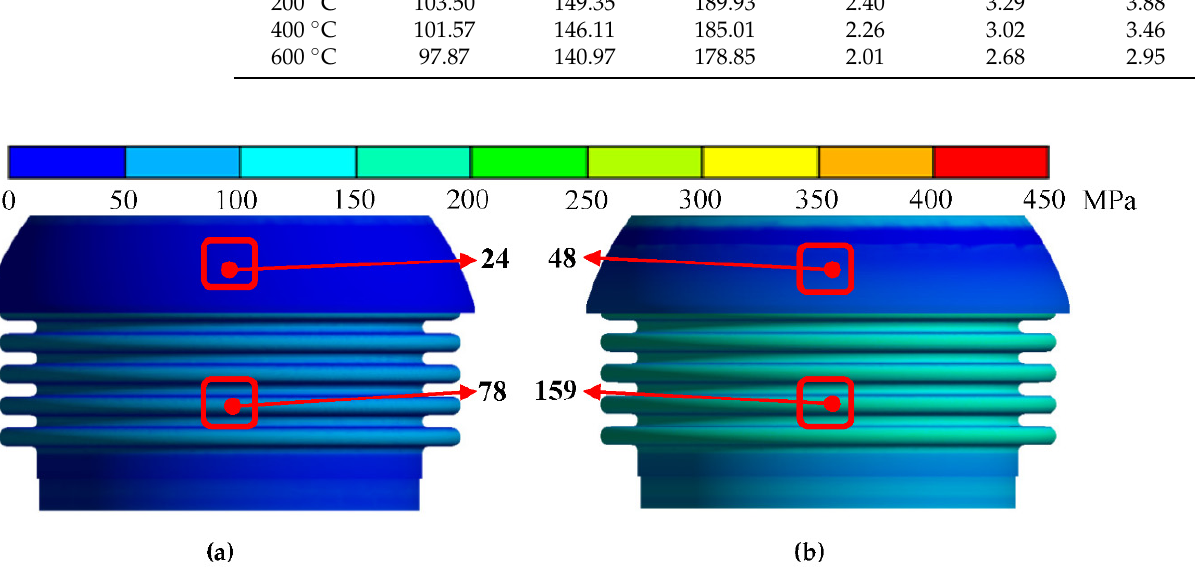
Figure 6. Stress nephogram under different pressures (T = 200 °C): ( a ) 1 MPa; ( b ) 2 MPa.